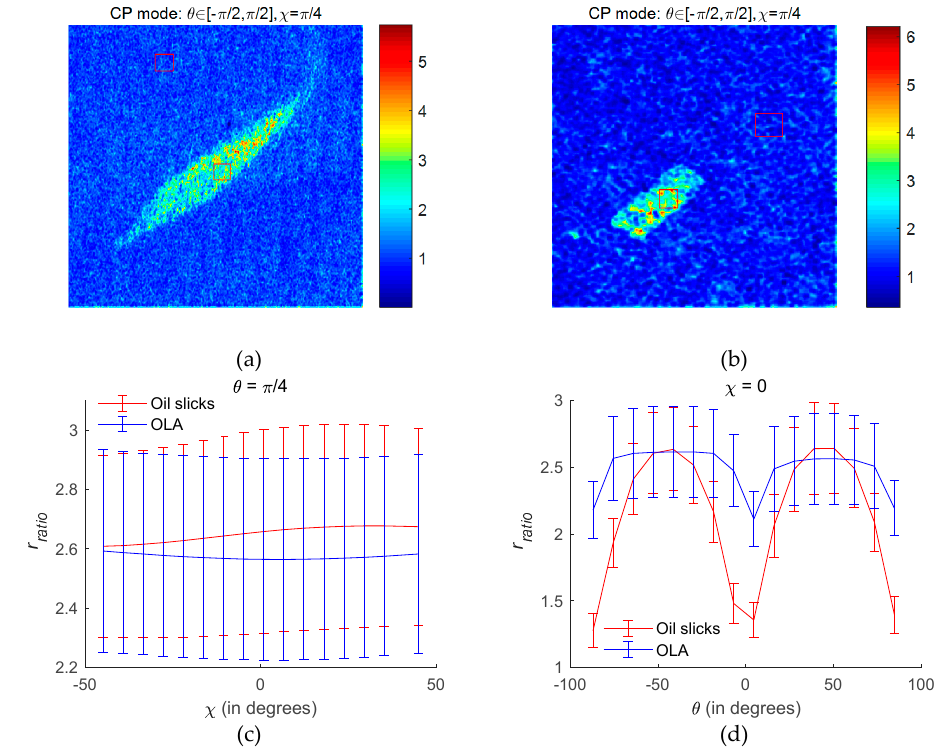
Figure 5. Damping ratios of oil slicks and OLA for the C-band SIR-C / X-SAR images with p.n. 49939 and p.n. 41370. ( a ) Damping ratio of oil slicks in the left circular mode; ( b ) damping ratio of OLA in the left circular mode; ( c ) variation of the damping ratio with χ changing from − π /4 to π /4; ( d ) variation of the damping ratio with θ changing from − π /2 + eps to π /2 − eps